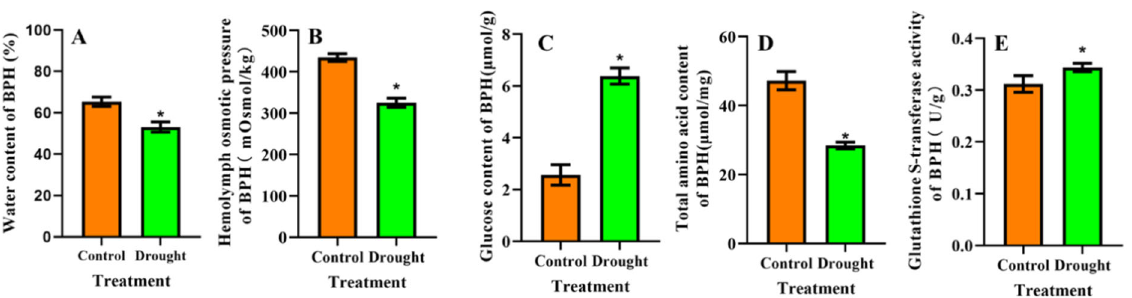
Figure 4. Physiological and biochemical changes in BPH fed on drought ‐ stressed and non ‐ stressed rice for 23 days. Changes in ( A ) water content, ( B ) osmotic pressure of hemolymph, ( C ) glucose content, ( D ) total amino acid content, and ( E ) GST activity. Data indicate means ± SE. * represents significant difference between drought ‐ stressed and non ‐ stressed BPH at p < 0.05 ( PLSD test). 3.4. Ultrastructural Changes in BPH Flight Muscles after Feeding on Drought ‐ Stressed Rice The length of flight muscle sarcomeres in drought ‐ stressed and non ‐ stressed BPH was significantly different (Figures 5 and 6). The sarcomere length in BPH fed on drought ‐